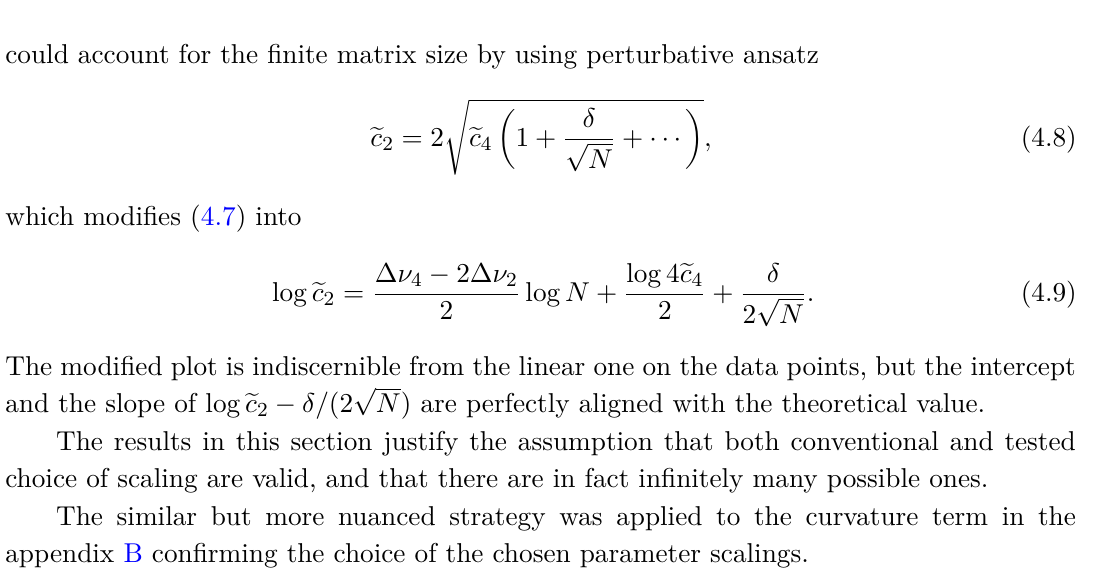
Figure 3 . l→↑↓ transition in the PP model for c 4 = 0 . 01 , 4 ≤ N ≤ 24 and fixed ν 2 = 1 , observed e as peaks in χ . The green/center data represents the desired choice of scaling ν 4 = ν 2 = 1 , the orange/inner sloped lines ∆ ν 4 = ± 0 . 5 and the red/outer sloped lines ∆ ν 4 = ± 1 . Pale-coloured stripes represent the 68% confidence intervals. Errorbars are mostly covered by data